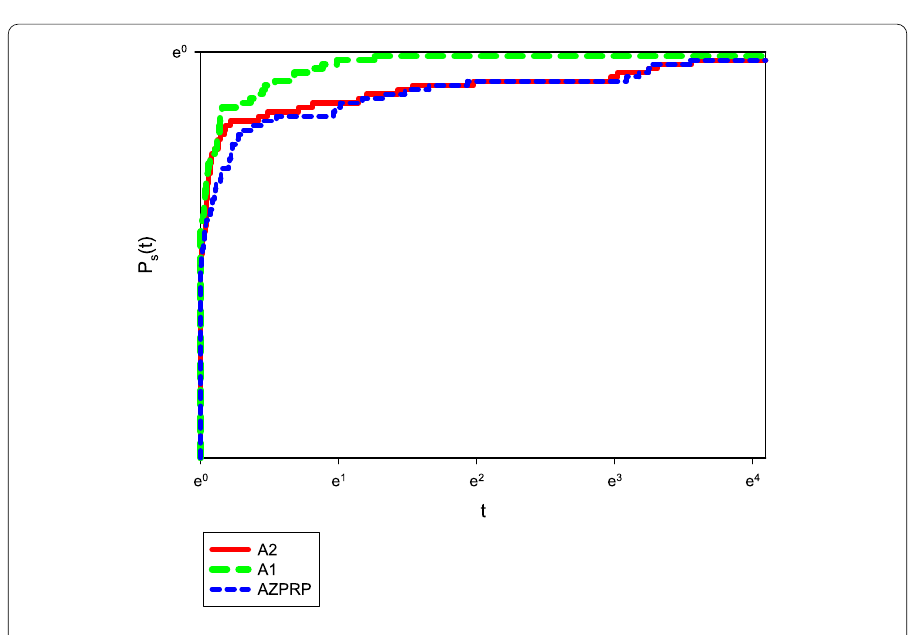
Figure 6 Performance profile based on the functions evaluation time